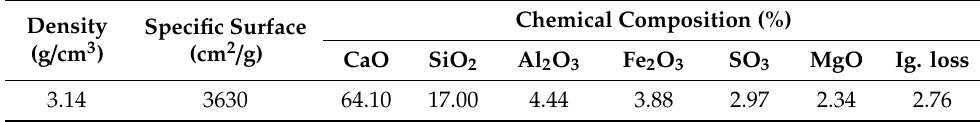
Table 1. Properties of ordinary Portland cement (Type I).